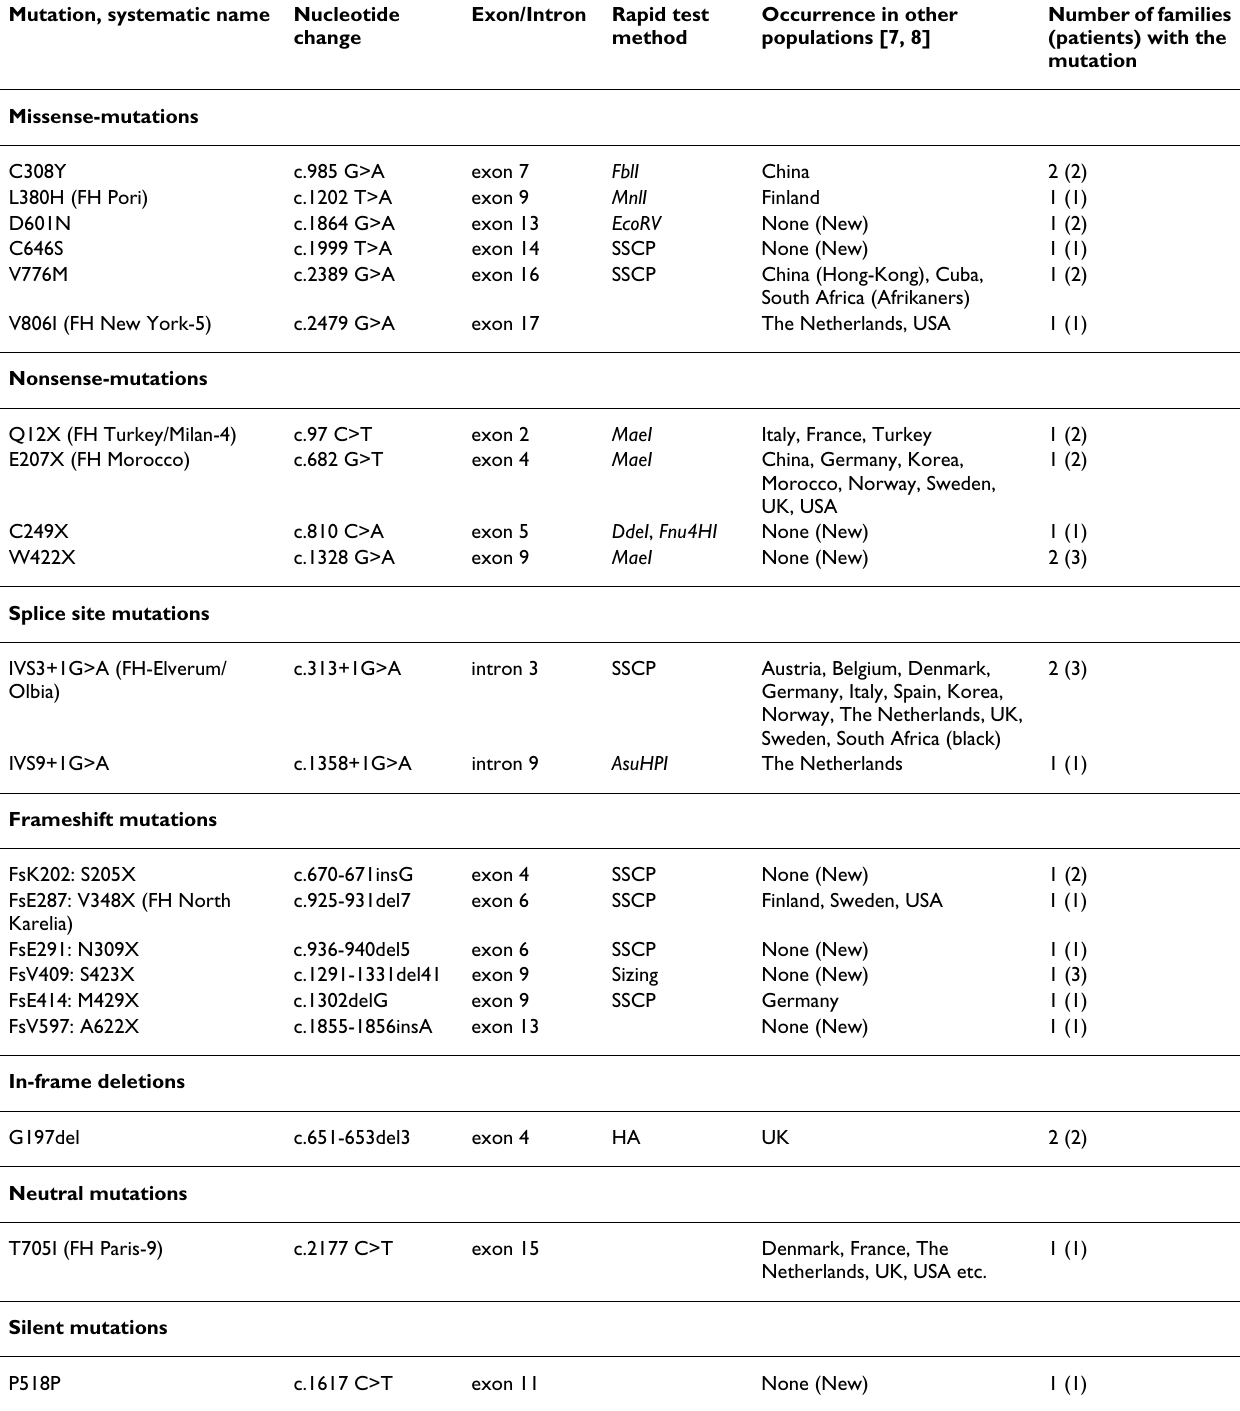
Table 1: List of the LDL receptor gene mutations found in the current study Mutation, systematic name Nucleotide